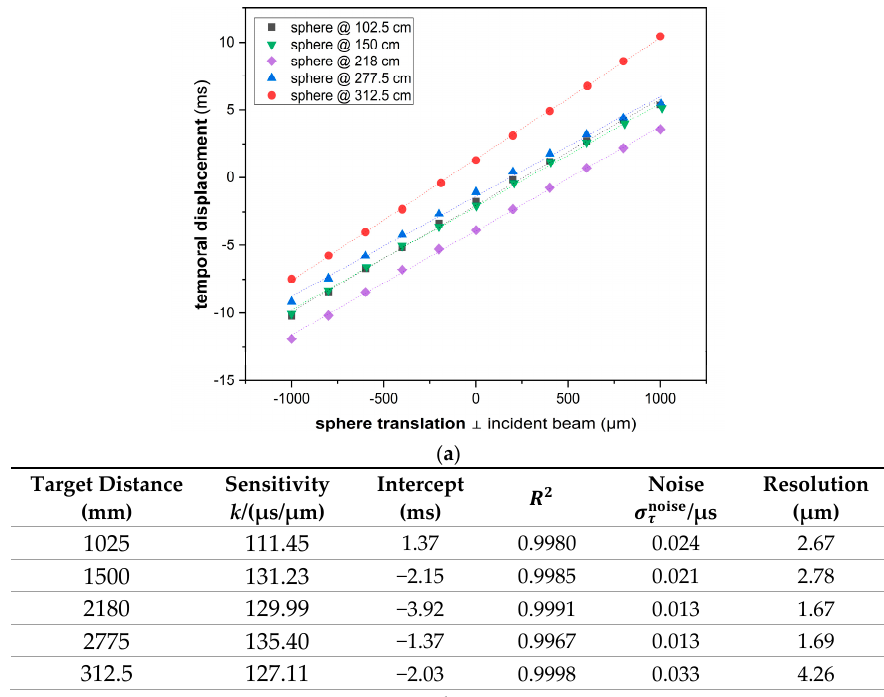
Figure 10. ( a ) Calibration curves at different distances to the target. ( b ) Calibration results. Lateral position of the target measured by a TESA TESATRONIC TT60 LVDT.